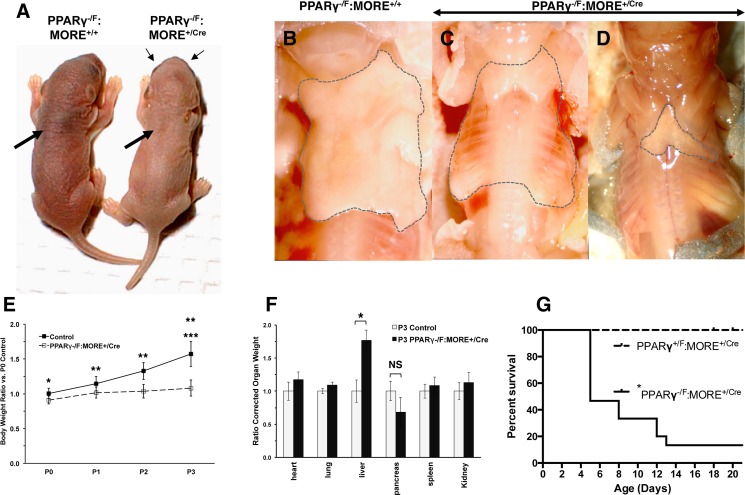
Failure to thrive and neonatal lethality in PPARγ-/F:MORE+/Cre mice.(A) PPARγ-/F:MORE+/Cre mice (right) show dermal hypopigmentation and an interscapular concavity (thick arrow, right panel) corresponding to the position of the interscapular brown fat pad in normal mice (thick arrow, left panel). Thin arrows designate retinal pigment indicating the paleness of this PPARγ-/F:MORE+/Cre neonate is not due to albinism. (B-D) Interscapular adipose tissue was virtually absent in PPARγ-/F:MORE+/Cre P3 neonates. The interscapular region contains BAT in control (dashed outline, B), but not in mutant (dashed outline, C) P3 neonates. Occasional mutants retained small amounts of interscapular tissue consisting primarily of white adipose tissue (WAT)-like tissue (dashed outline, D). (E) Body weight of neonatal mice from PPARγF/F x PPARγ+/-:MORE+/Cre matings. PPARγ-/F:MORE+/Cre mice are slightly smaller than littermates at birth (* p < 0.002), subsequently fail to gain weight in spite of apparently normal suckling and the appearance of a milk spot and are markedly smaller than littermates at P3 (*** p = 0.00001). In contrast, littermates gain weight daily (** p < 0.0003 vs. previous day). (F) Organ weights showing selective hepatomegaly in P3 PPARγ-/F:MORE+/Cre mice (* p < 0.05; NS, p > 0.05). (G) Neonatal lethality of PPARγ-/F:MORE+/Cre mice. The majority of PPARγ-/F:MORE+/Cre mice were euthanized at humane endpoints or found dead between P5 and P13 (* p < 0.0001). In E and F “Control” indicates combined results for PPARγ+/F:MORE+/+, PPARγ-/F:MORE+/+ and PPARγ+/F:MORE+/Cre neonates.